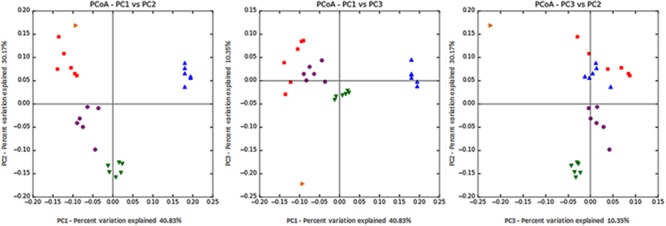
Principal coordinate analysis (PCoA) of 16S rRNA using the weighted Unifrac distance metric (PC1 = 40.8%, PC2 = 30.2%, and PC3 = 10.3%). Orange: original rumen fluid sample taken from cows, Red: control, Blue: monensin, Purple: S. striata-Low, and Green: S. striata-High. S. striata: Scrophularia striata extract.